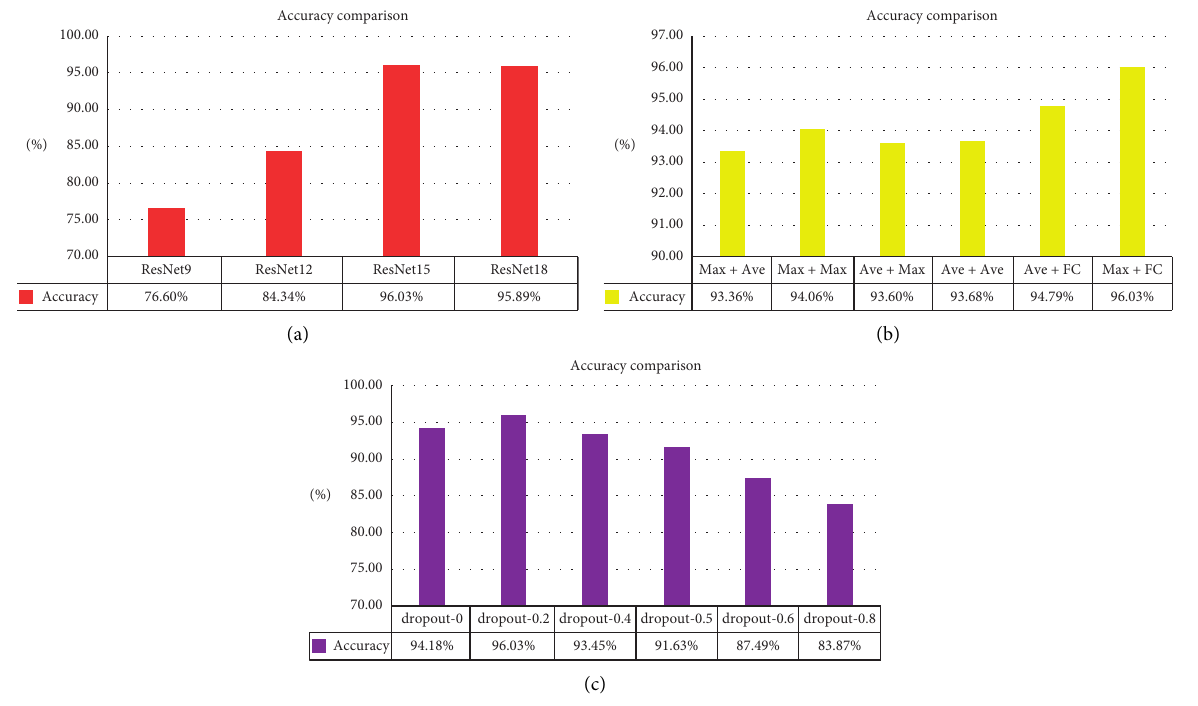
Figure 6: Histogram comparison of accuracy. (a) Accuracy comparison in depth. (b) Accuracy comparison of different pooling layers. (c) Accuracy comparison with different dropout